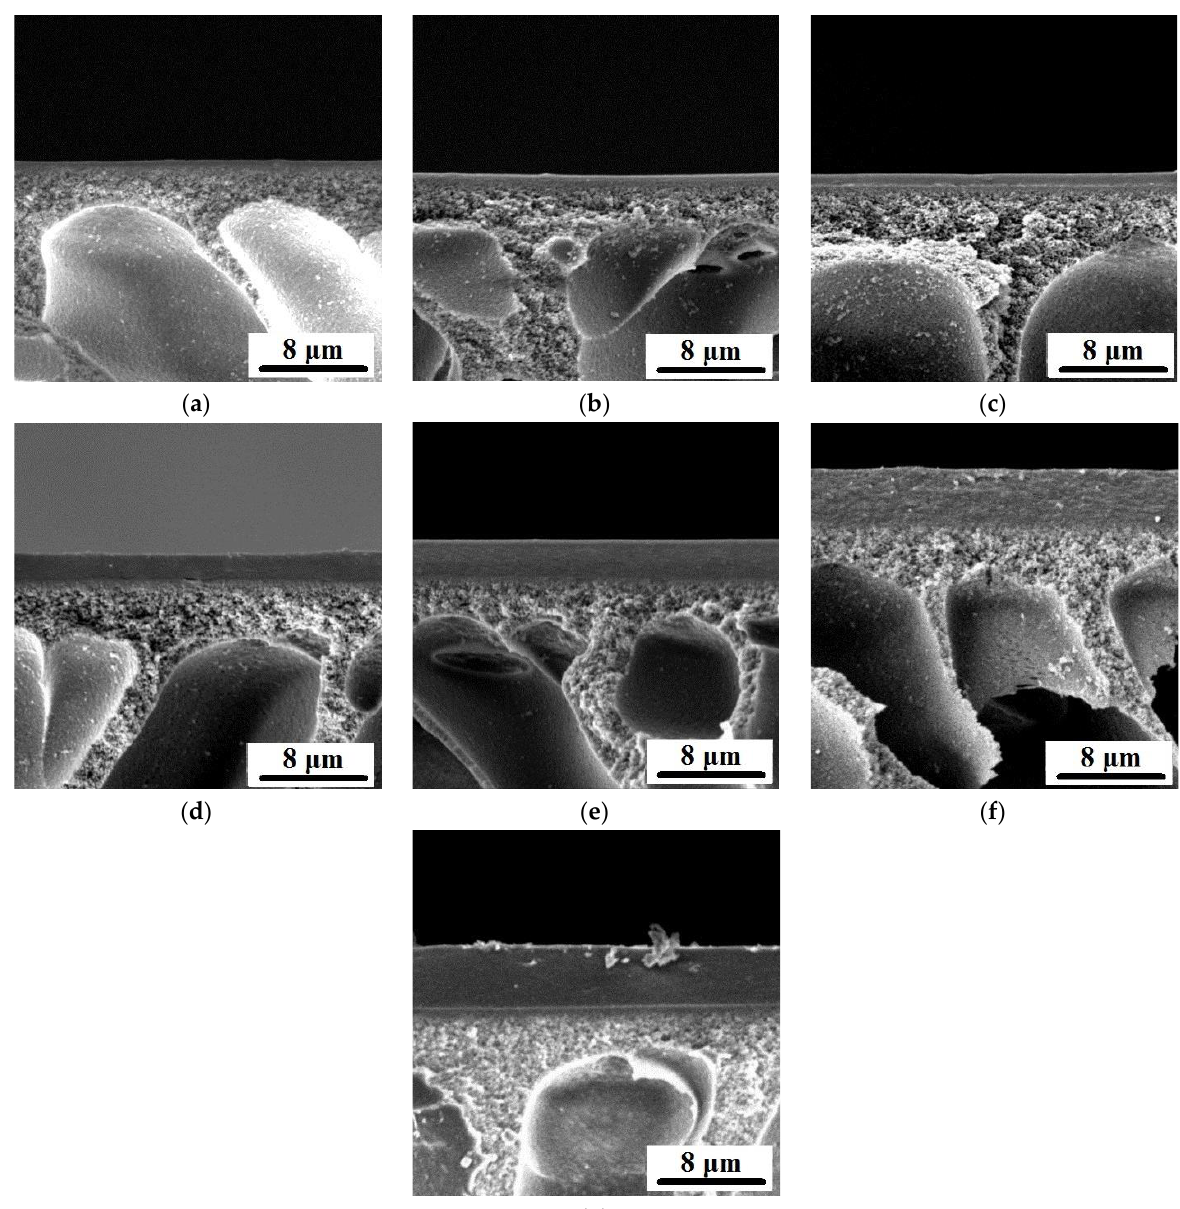
Figure 4. SEM microphotographs of the cross-sections of dynamic composite membranes: ( a ) — D0, ( b ) — D5, ( c ) — D10, ( d ) — D15, ( e ) — D20, ( f ) — D30, ( g ) — D40.